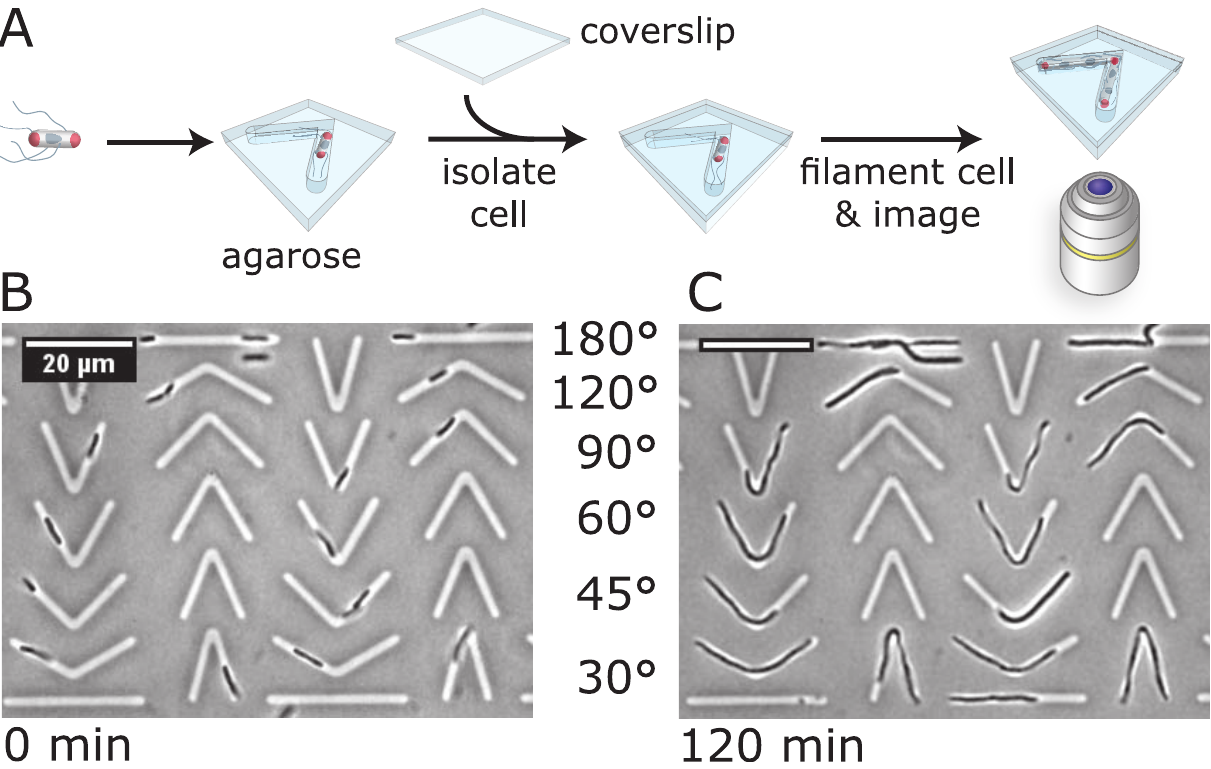
Figure 1. Methodology to engineer curvature in bacterial cells. (A) A schematic diagram depicting the approach for engineering bacterial cell wall curvature by growing filamentous cells of bacteria in angled microchannels. We confined individual planktonic cells in microchannels printed into layers of agarose infused with LB nutrient media to physically impose cell curvature upon filamented bacterial cells. Bacteria were filamented using antibiotics that inhibit cell division. (B–C) Representative images of an experiment using E. coli FB76 cells comparing time points at (B) 0 min of growth and (C) 120 min of growth. In this experiment we filamented cells by infusing the agarose with 25 m g/mL of cephalexin. The values shown depict the angle that connects the two straight channel segments. Scale bars: 20 m m.